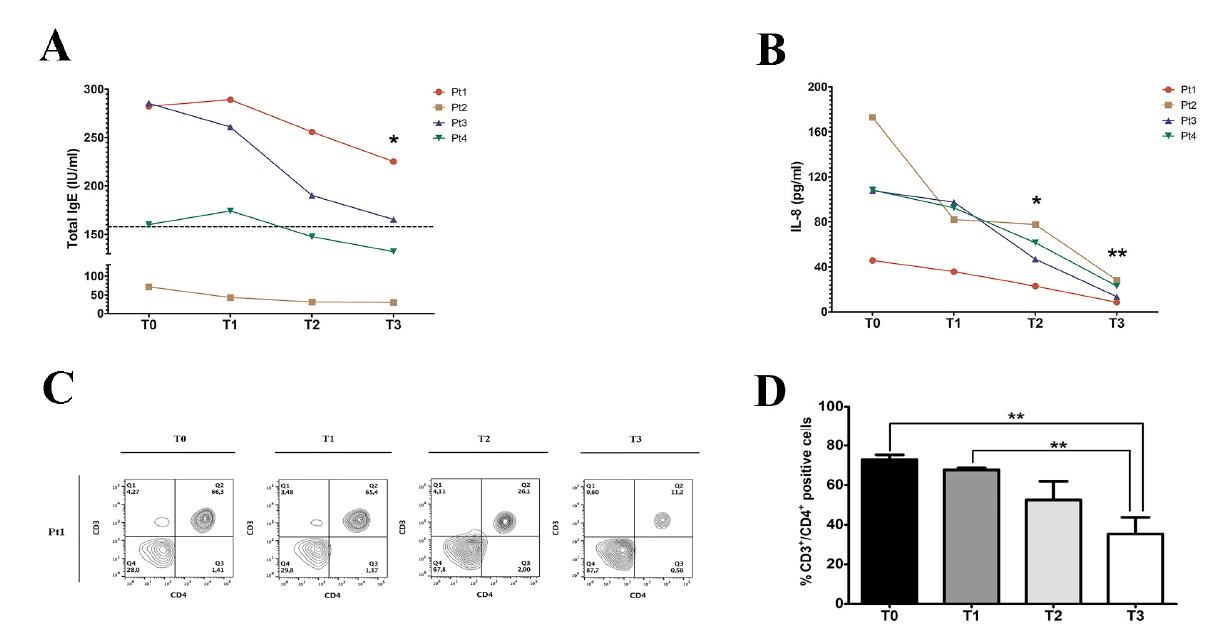
Figure 2. IgE ( A ) and IL-8 ( B ) levels in serum of patients with CRSwNP before (T0) and after (T1, T2, T3) treatment with Dupilumab; dotted line indicates the reference value threshold. ( C ) Flow cytometry assay of circulating CD3 + /CD4 + T cells in blood of the most representative patient (Pt1) during the observation; the percentage of CD3 + /CD4 + T cells was reported in the Q2 square of each plot panel. ( D ) Percentage of CD3 + /CD4 + T cells in the overall patients at the indicated timepoints; data are reported as the mean ± s.e.m. Data were analyzed by ANOVA for repeated measures, followed by Bonferroni’s multiple comparison test; * p < 0.05, ** p < 0.01.